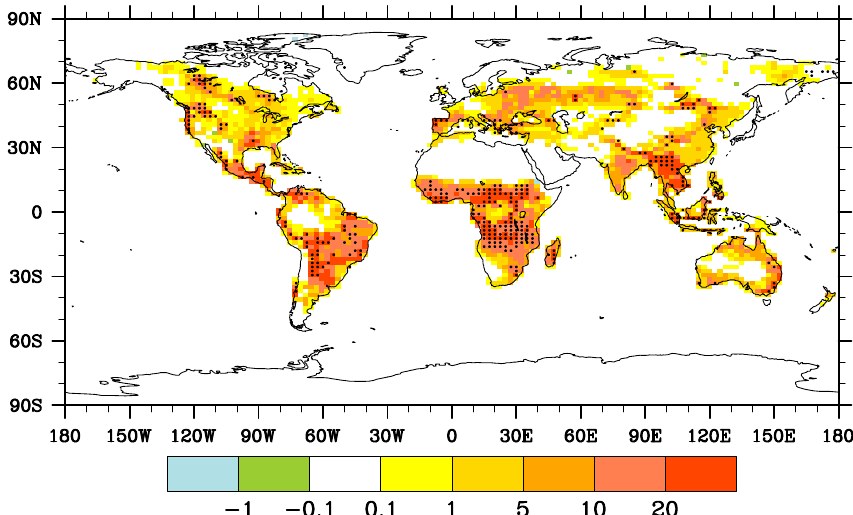
Fig. 3. Difference (fire-on minus fire-off) in the 1990–1999 average NEE from fire-on and fire-off simulations. Difference passed the student’s t test at the α = 0 . 05 significance level is stippled. Unit is g Cm − 2 yr − 1 .